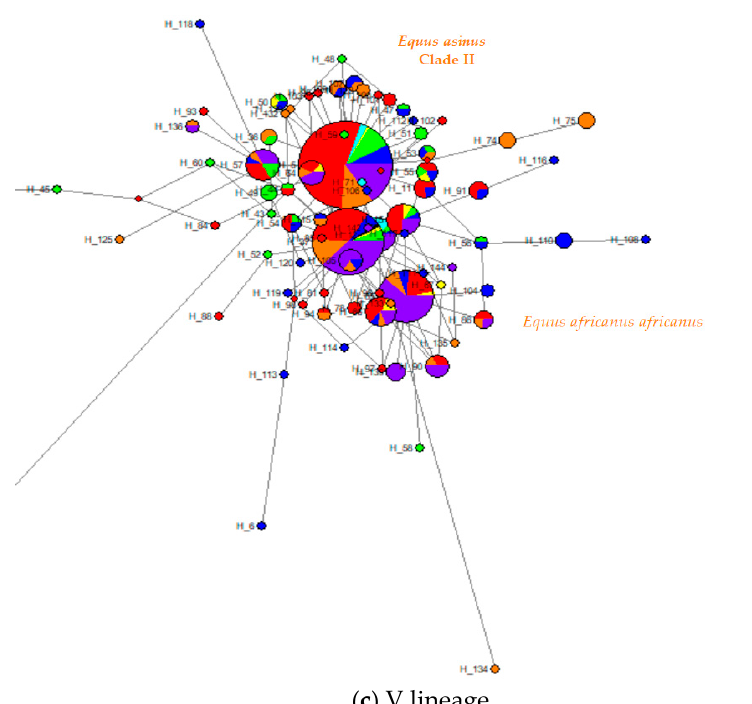
Figure 7. ( a ) MJN based on the 16 different regions of Turkish native donkey populations and the 429 deposited sequences of donkey from GenBank database. Circles are proportional to the haplotypes frequencies; black circles are median vectors (mv), performing extant unsampled or extinct ancestral sequences; in red the number of mutation points with respect to the reference sequence X97337. ( b ) IV; Clade I: Somali lineages ( Equus asinus somalicus ), ( c ) V; Clade II: Nubian lineage ( Equus africanus africanus ). (Red: Turkish native donkey populations; Blue: [16], Green: [26], Yellow: [15], Orange: [30], Purple: [17], White: [11], Turquoise: [28], Grey: [38]).